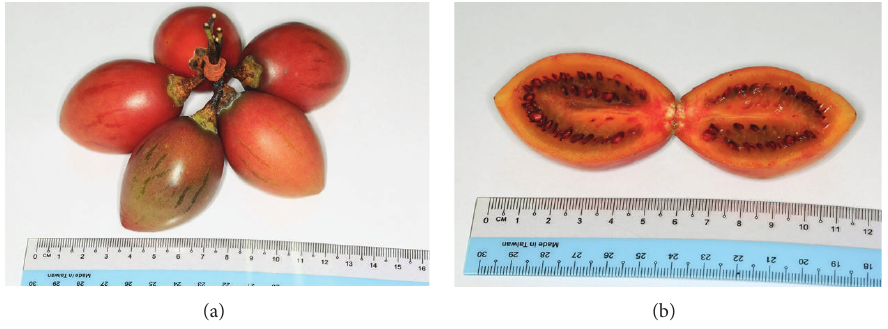
Figure 1: (a) Fruit of C. betacea and (b) cross-section of C. betacea